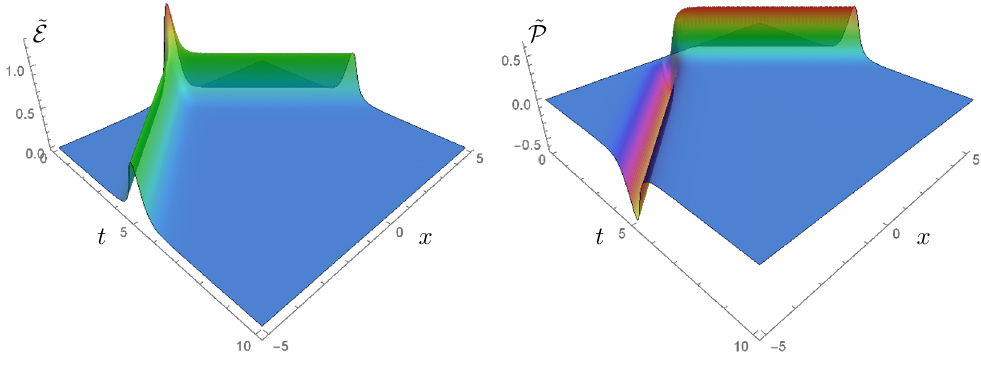
Figure 6 . Pro(cid:12)les of the normalized energy density ~ E = E =E and momentum density ~ P = P =E , with E = (cid:1) =(cid:11) , as a function of t and x for a local quench with (cid:11) = 1 = 2. The parameter (cid:11) measures the initial spread of the excitations around x = 0, which is estimated to be of order O ( (cid:11) ). The initial perturbation generates two shocks, moving to the left and to the right respectively, that move at the speed of light. The heights of these shocks remain constant due to energy conservation in the